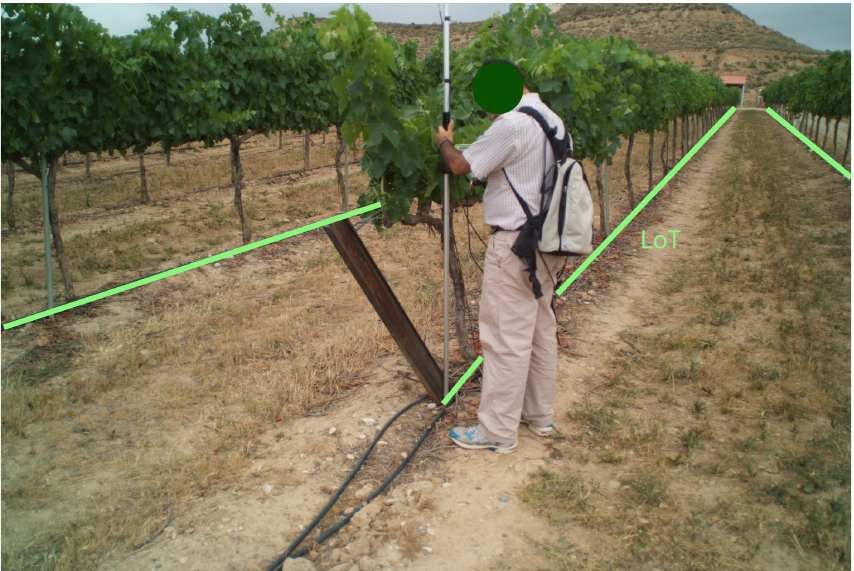
Figure 6. Process of measuring the line of trunks (LoT) with RTK-GPS.